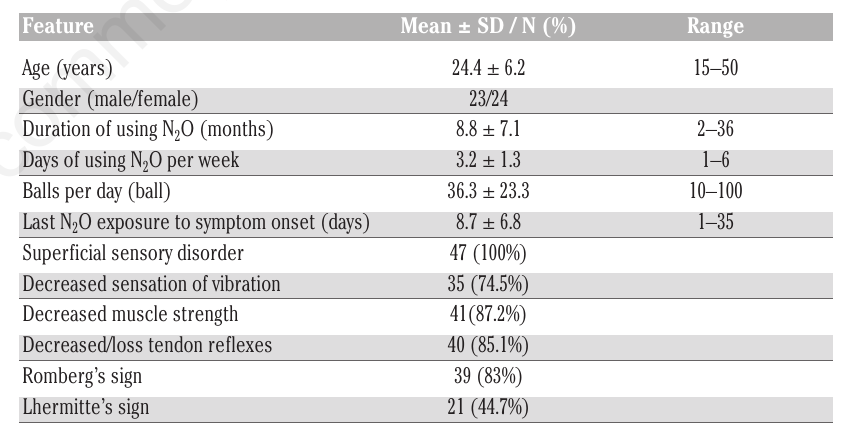
Figure 1. A 17-year-old female patient, with a history of using N 2 O for a long time. (A) Spinal cord injury appeared as hyperintense on the sagittal T2W image, from C1 to C6. (B) Axial T2W image, with hyperintense lesion located in the posterior column, with bilateral symmetry, appearing as an “inverted V” sign. Table 1. Patient demographics.